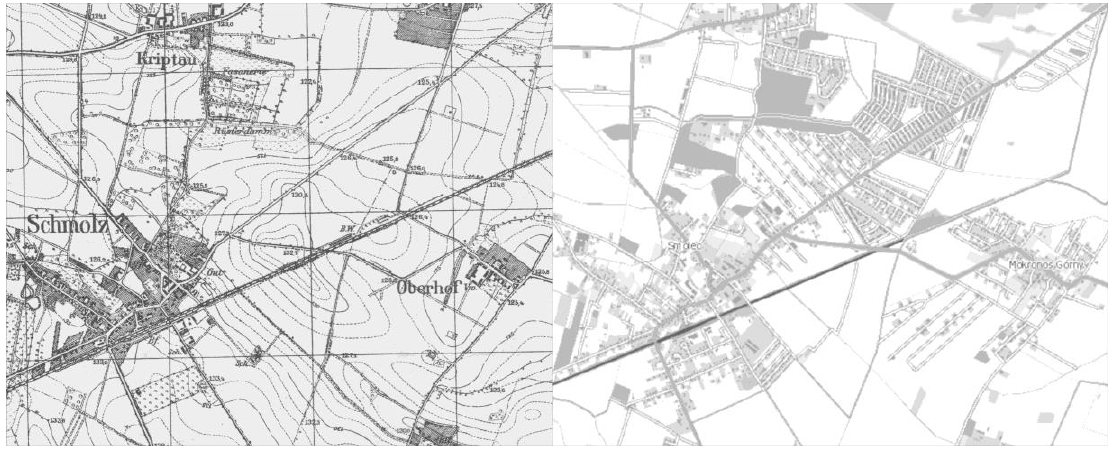
Fig. 10. Morphological transformation in Smolec (Kąty Wrocławskie commune)